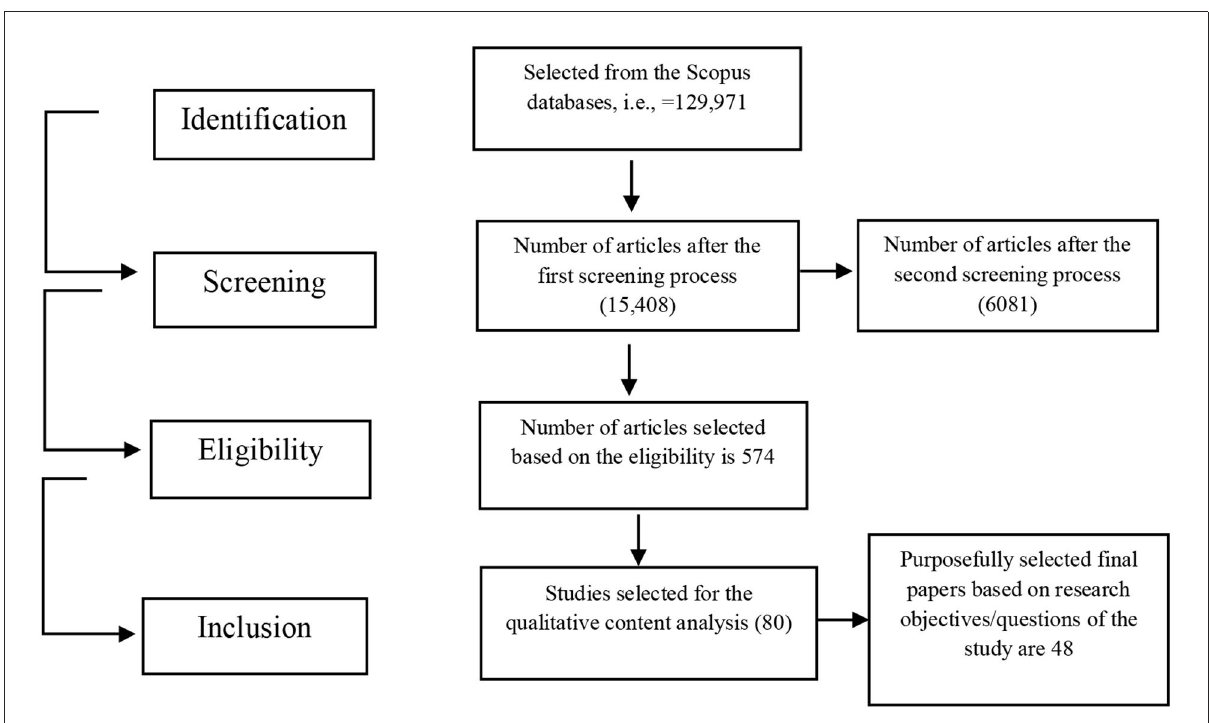
FIGURE2 Literature search process represented through the data flow